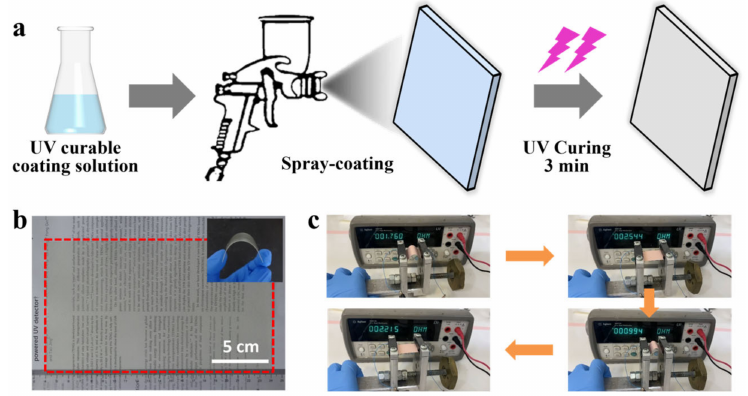
Figure 1. Fabrication process and flexibility of the triboelectric coating. ( a ) Fabrication of the triboelectric coating based on the spray-coating method. ( b ) The image of the large-area triboelectric coating on the PET substrate. The insert shows that the coating is flexible. ( c ) Resistance changes during repeated bending.